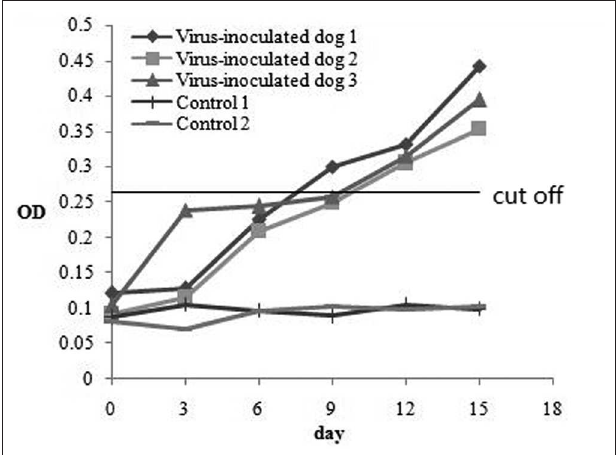
FIGURE 5 | The antibody production of CanineCV in artificially experimental infected